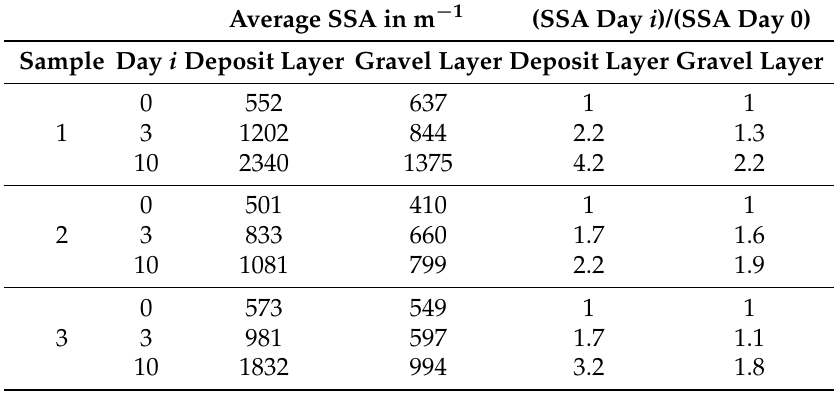
Table A4. Average SSA for the deposit and gravel layers and increase over time. Computations were performed for an ROI of